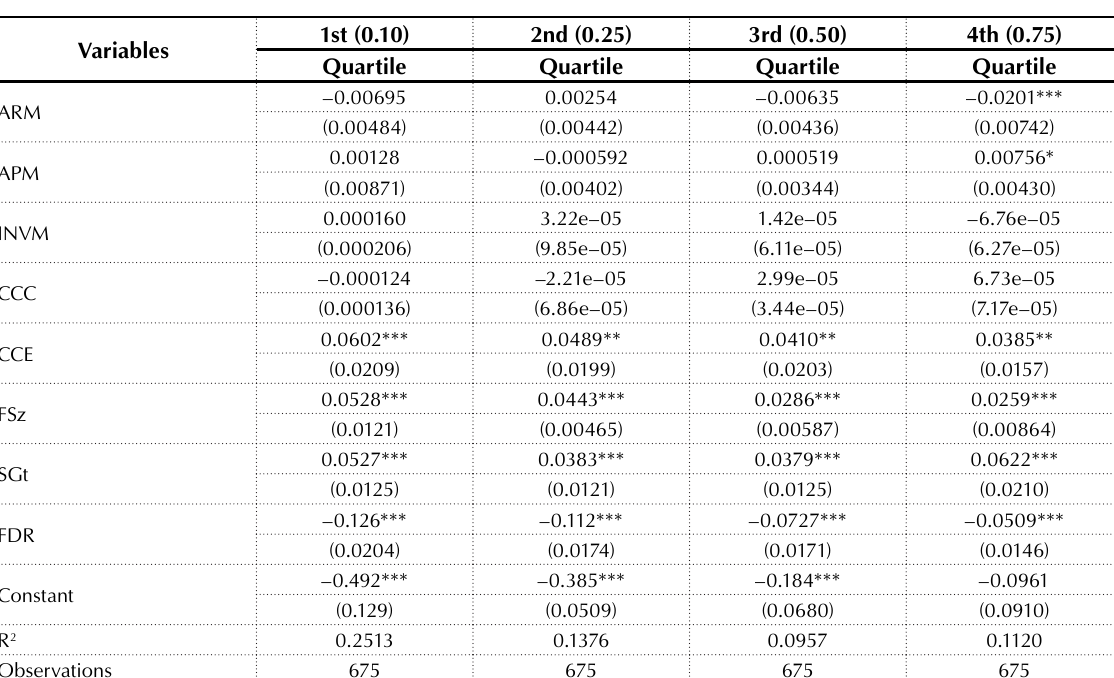
Table 7. Result of quantile regression (QR) for the ROA